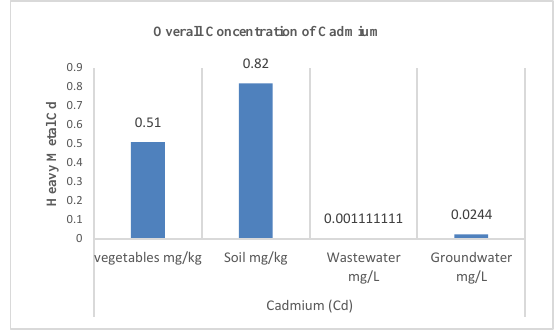
Figure 4: Overall Concentration of Cadmium